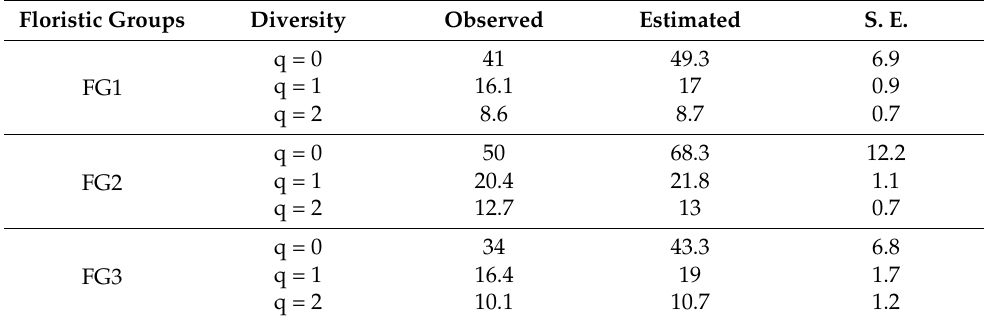
Table 2. Species richness (q = 0), exponential of Shannon index (q = 1), and inverse of Simpson index (q = 2) based on the Hill numbers obtained by a bootstrap method based on 50 replications, for three floristic group in Montane